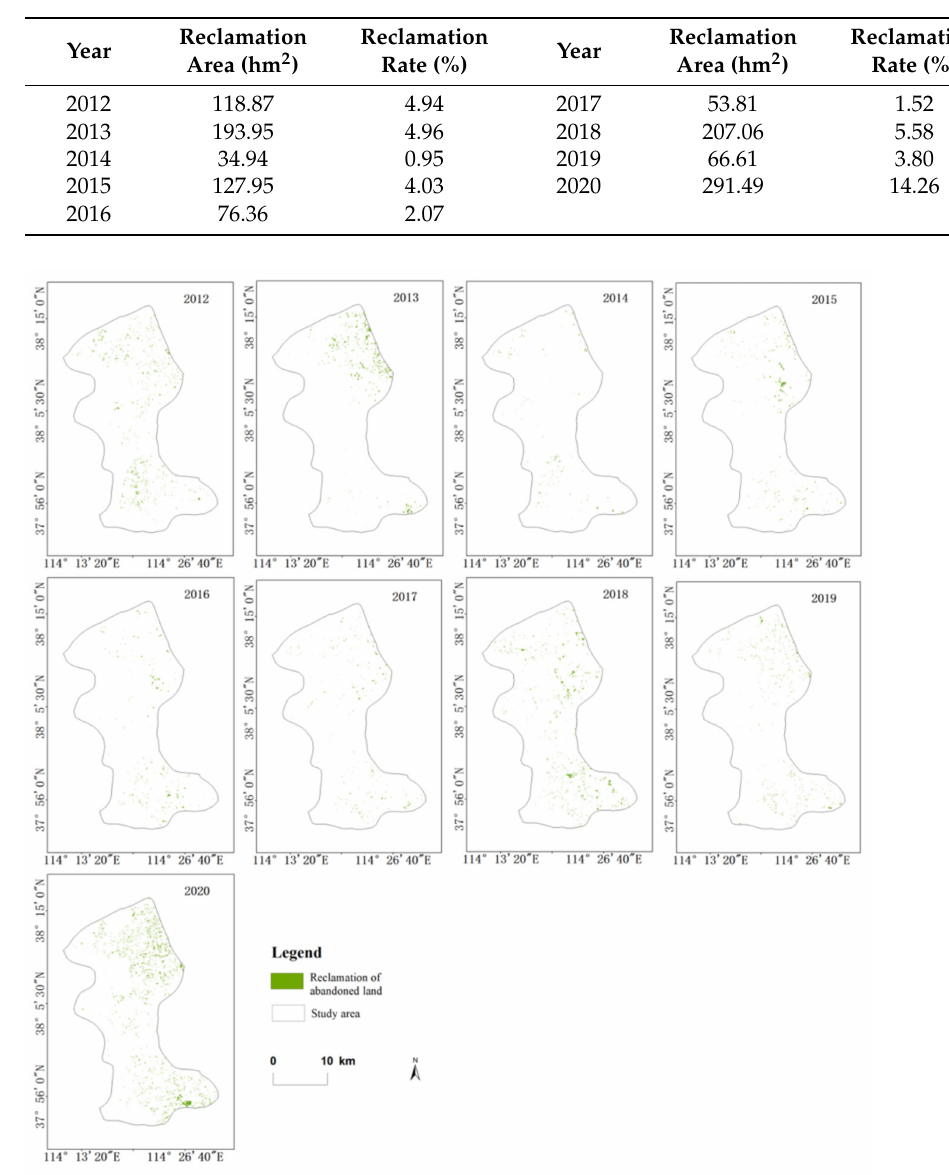
Table 4. Statistical results for the reclamation of abandoned farmland for the period of 2012–2020.